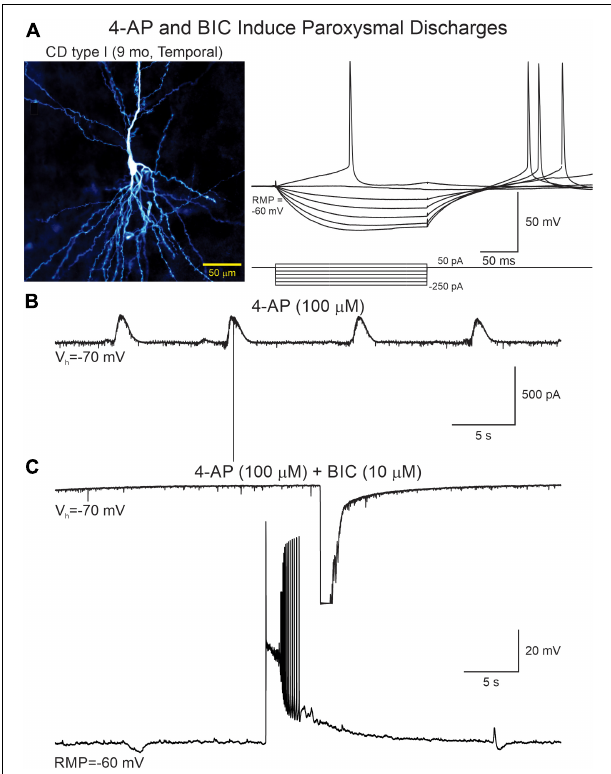
FIGURE 6 | 4-AP and BIC increase network excitability. (A) A CPN from a CD type I case was recorded in current and voltage clamp modes. Left panel shows the cell after biocytin processing. Right panel shows voltage changes induced by hyperpolarizing and depolarizing current pulses. (B) After addition of 4-AP rhythmic oscillations with scattered action potentials were seen. (C) Addition of BIC eliminated the 4-AP oscillations but simultaneously increased network excitability as demonstrated by the generation of paroxysmal discharges recorded in both voltage clamp (top trace, truncated due to saturation) and current clamp (lower trace).